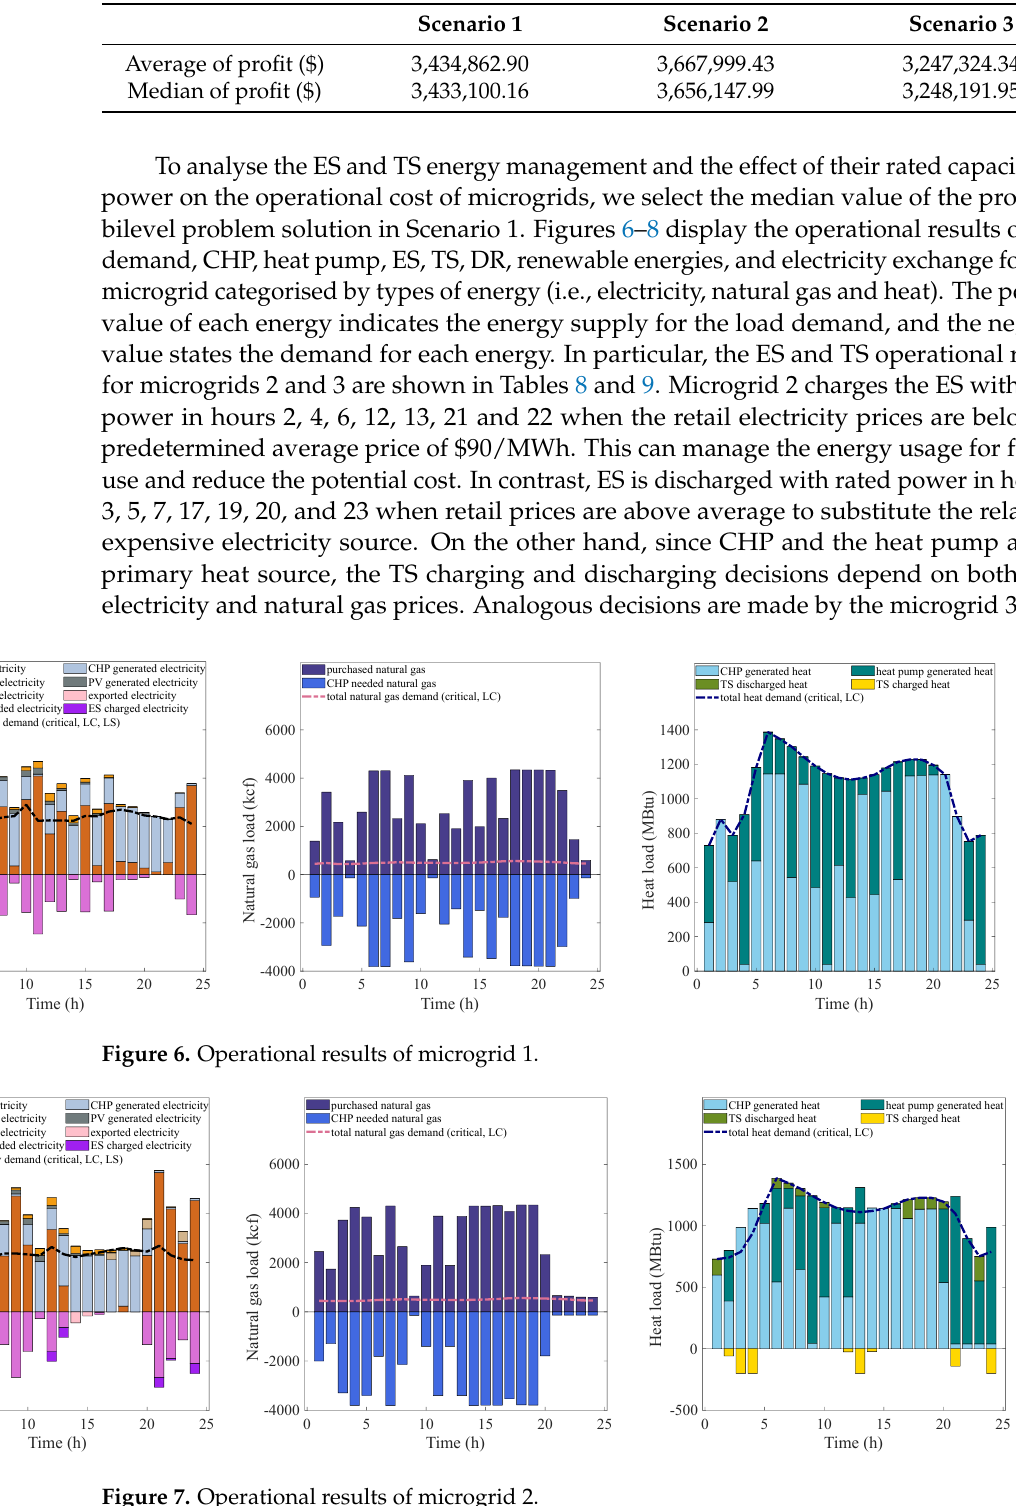
21 of 32 Table 6. Microgrids energy management results under customised and uniform pricing schemes. – : Not applicable Customised